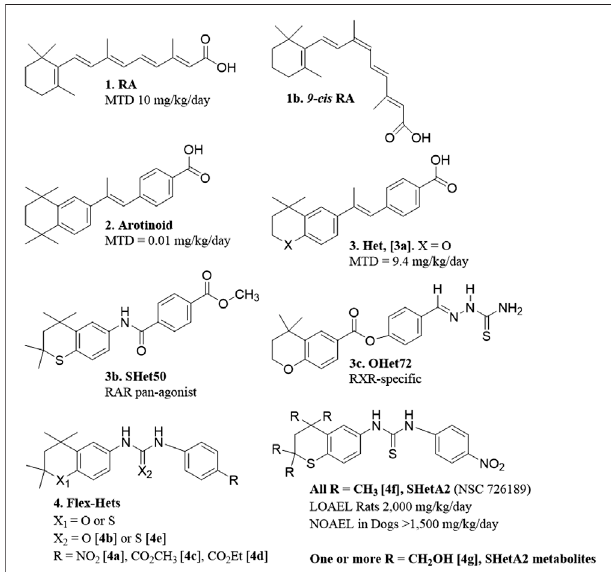
FIGURE 1 | Structures and toxicity endpoints of hets and fl